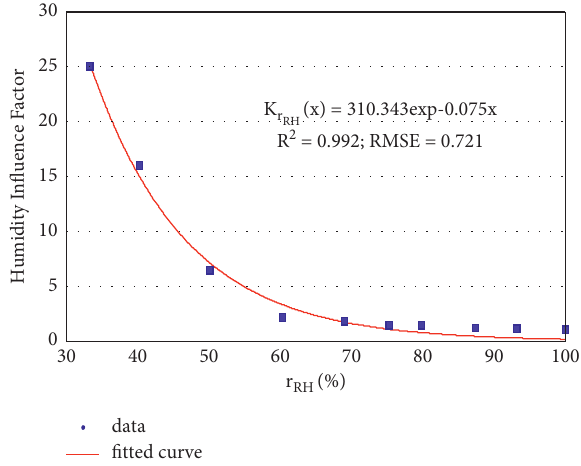
Figure 16: Humidity influence factor on electric resistance relationship.